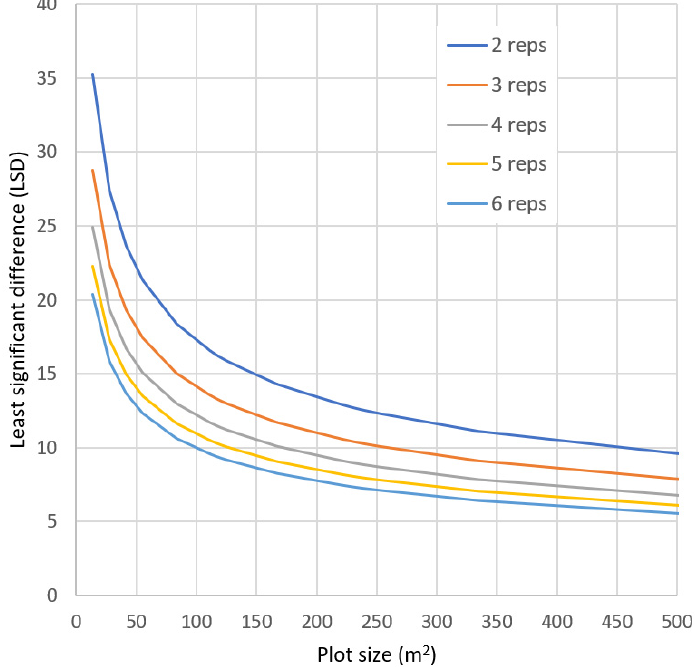
Figure 4. Relationship between plot size and least significant difference for trials with varying replicates using data from six uniformity trials conducted in the Upper Midwest region of the United States.